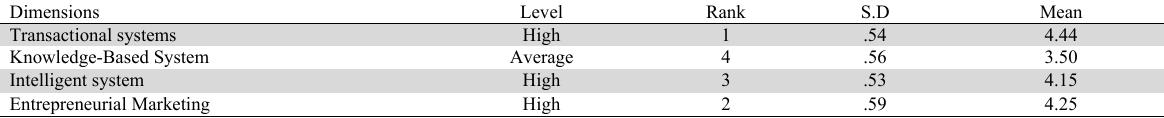
Descriptive Statistics for Latent